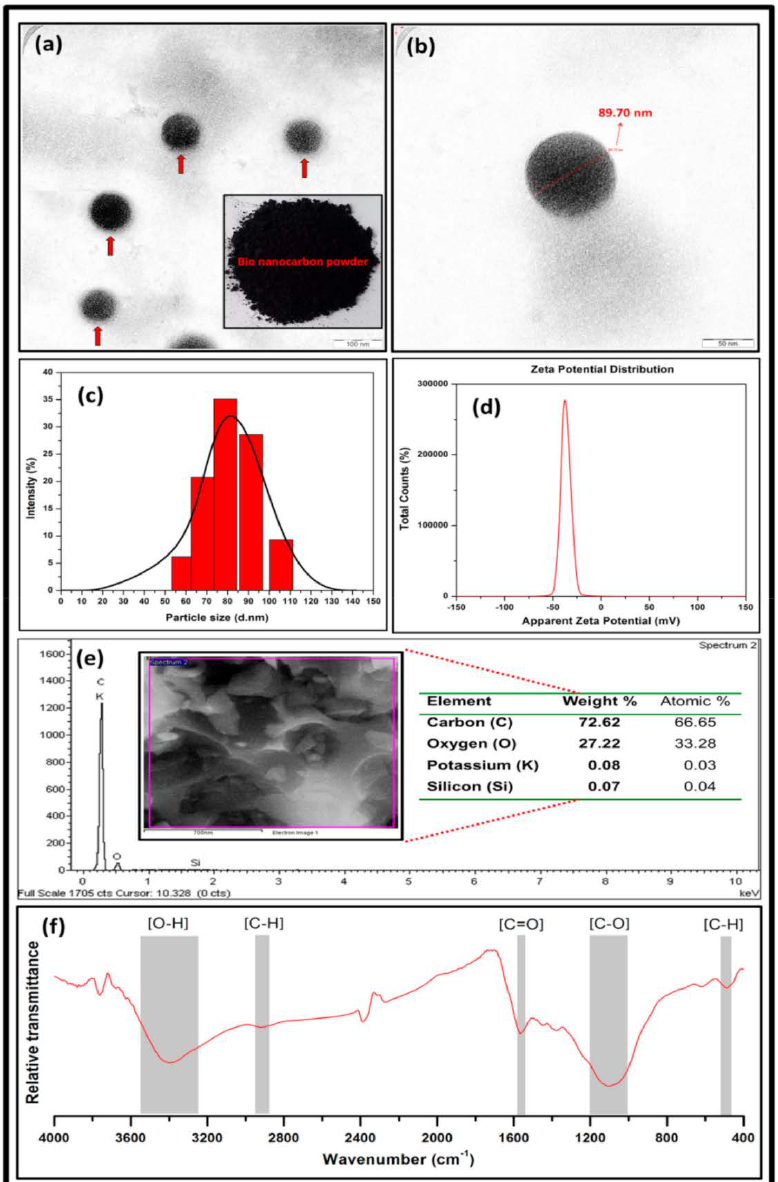
Figure 2. TEM micrograph ( a ) and nanosized powder (inset Figure) of bionanocarbon, ( b ) TEM micrograph of single nanoparticle of bionanocarbon, ( c ) particle size distribution of activated bio- nanocarbon, ( d ) potential zeta distribution of bionanocarbon, ( e ) elemental analysis of bionanocarbon, and ( f ) FT-IR spectra of